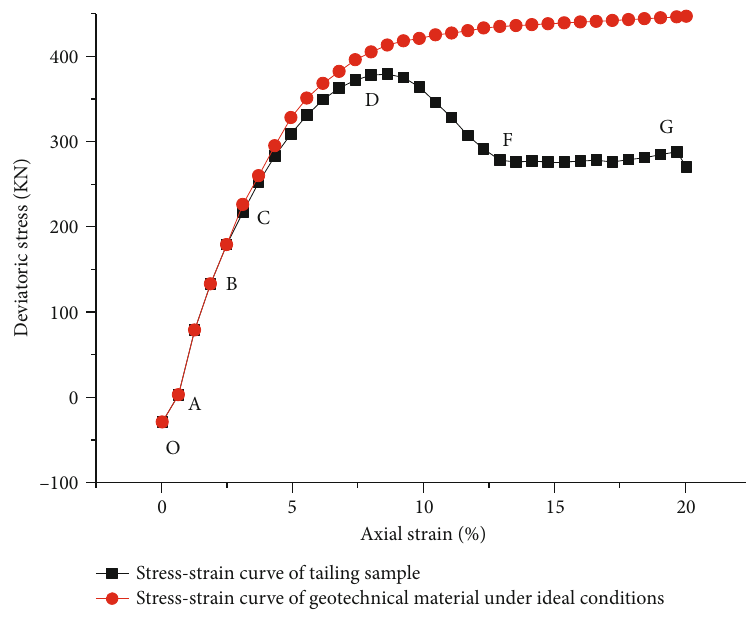
Figure 4: Stress-strain curve of tailings under con fi ning pressure of